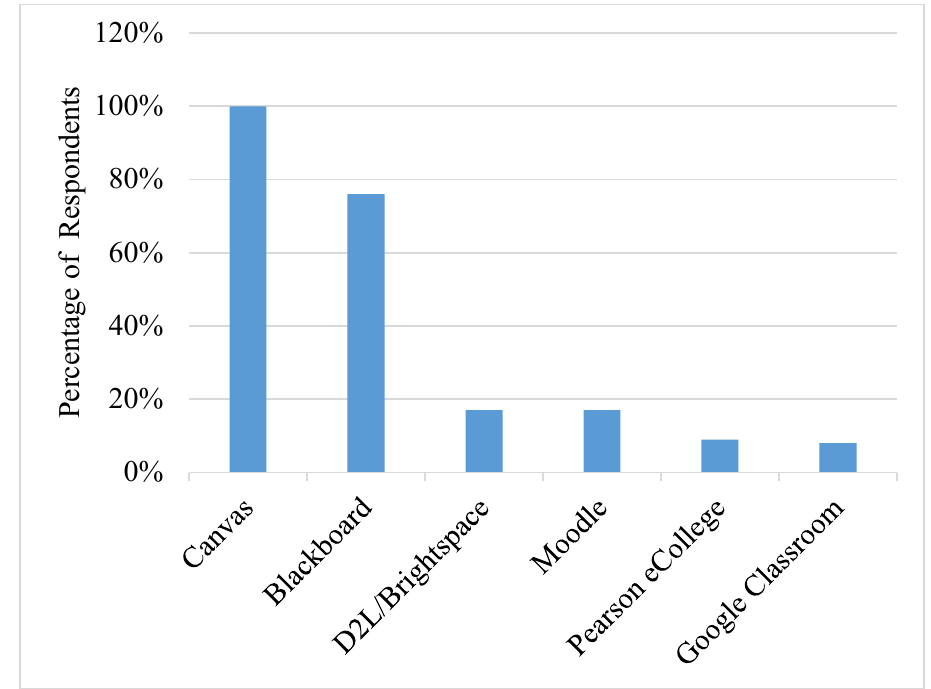
Figure 4 . Learning management systems used by